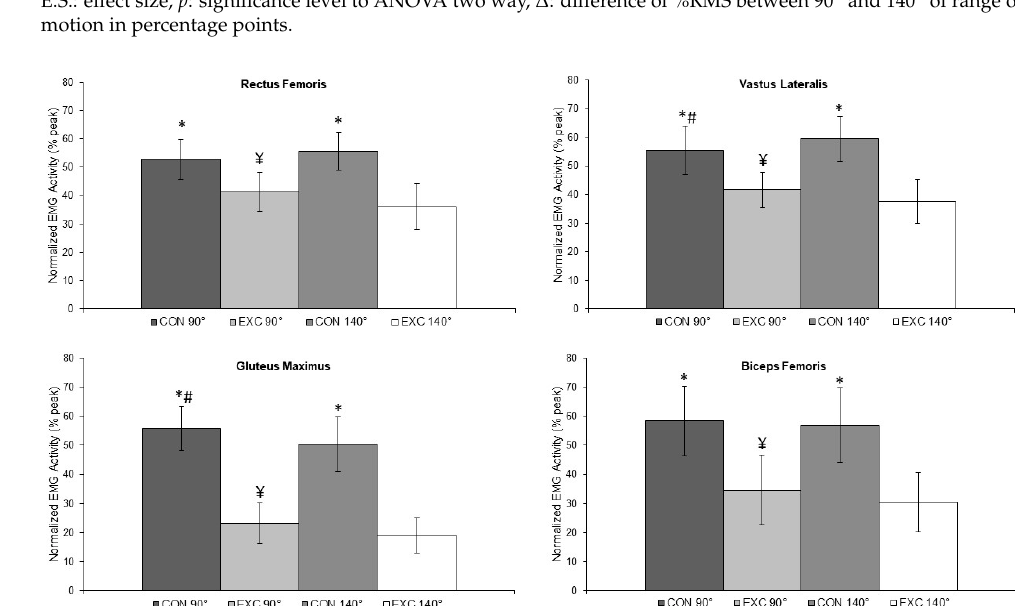
Figure 1. Muscle activation during the squat performed by women at 90° and 140° of range of motion * Differences between concentric and eccentric actions; ¥ Differences between eccentric actions; # Differences between concentric actions.